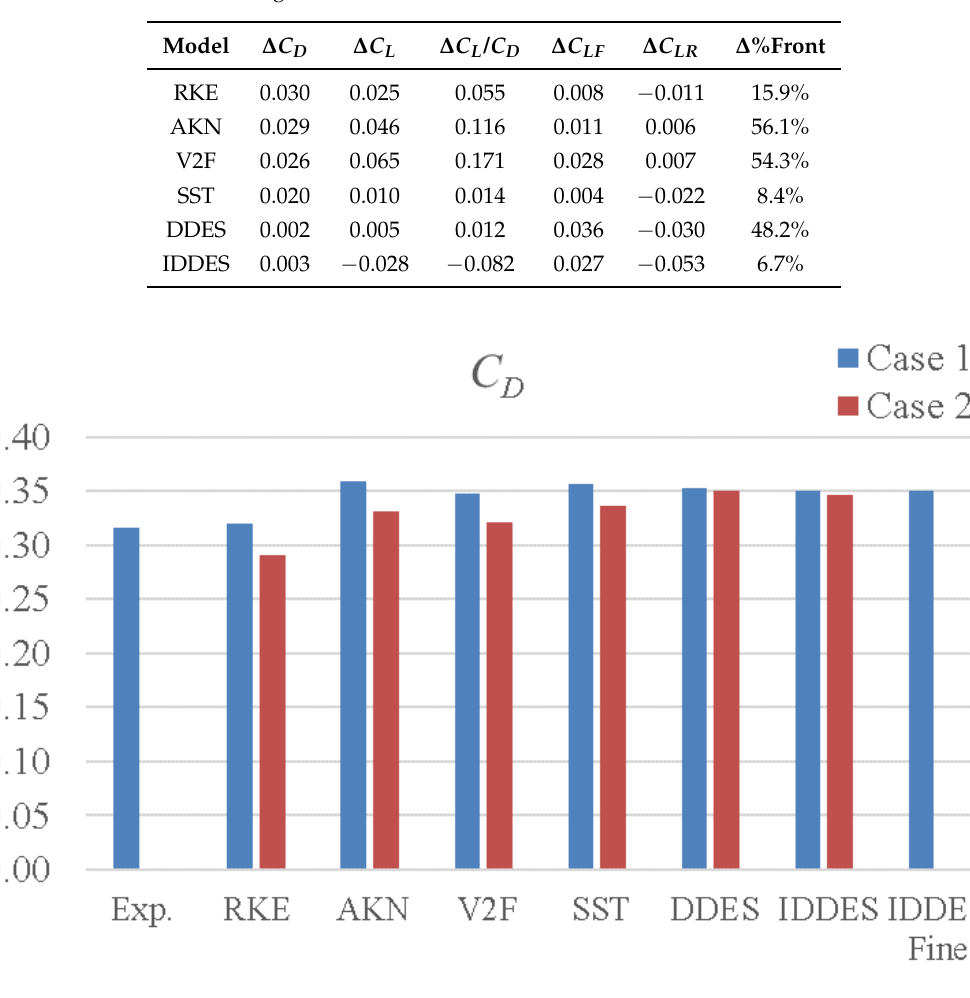
Figure 7. C D for both cases from the predictions of all turbulence models and the